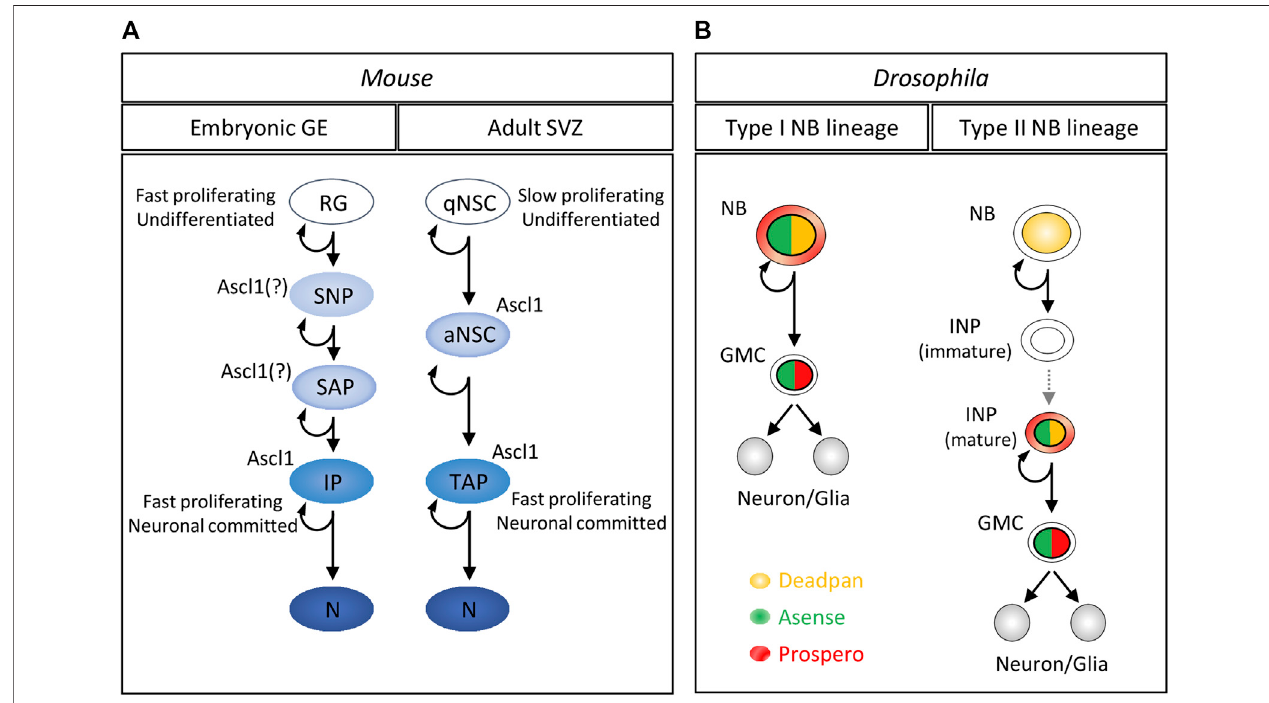
FIGURE 2 | Expression ofAscl1 and Ase in neurogeniclineages of vertebrates and fl ies (A) Schematicdiagramofan embryonic(lateralganglioniceminence) and an adult (lateralventricle)neurogeniclineageinmousebrain.Intheembryoniclineage,Ascl1expressionisexcludedfromRadialGlianeuralstemcells,startinginmorerestrictedprogeny.In the adult SVZ, Ascl1 expression starts in activated NS cells as they exit quiescence, being maintained in fast proliferating, neuronal committed progenitors. Blue color gradient indicates progression along the neuronal lineage GE, ganglionic eminence; SVZ, sub-ventricular zone; RG, Radial glia; SNP, short neural precursors; SAP, sup-apical progenitor; IP, intermediate progenitor; N, neuron. qNSC, quiescent neural stem cell; aNSC, activated neural stem cell; TAP, transiently amplifying progenitor. (B) Schematic diagram of thedivision patternsoftypeIand type II neuroblastlineages in the centralbrain of Drosophila larvae.Ase is expressed in Type INBs that divideasymmetrically to self- renew and produce a smaller GMC, which maintains Ase expression. By contrast, Type II neuroblasts lack Ase expression. In this lineage, Ase expression starts in INPs as they mature,andissubsequentlyterminatedinGMCsuponnucleartranslocationofPros(whichtriggersanirreversibledecisiontowardsdifferentiation).Colorsrepresentcytoplasmicor nuclearexpressionofeachtranscriptionfactor — Dpn(yellow);Ase(green);Pros(red).NB,neuroblast;GMC,ganglionmothercell;N,neuron;INP,intermediateneuralprogenitor.